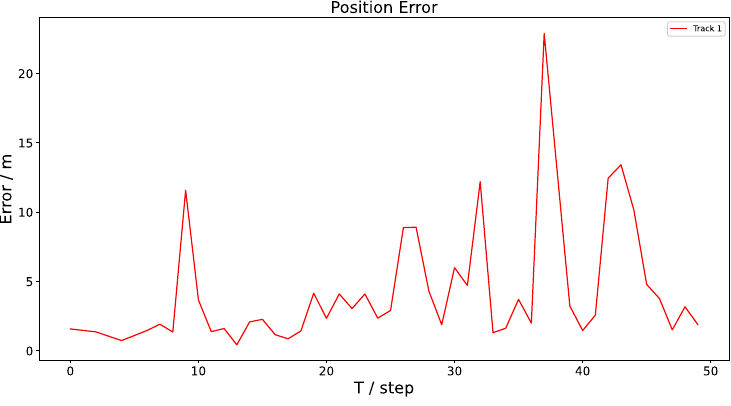
Figure 15. Tracking error between prediction and actual track (CMKF-REMTT). Figure 16. Tracking error between the prediction and actual track (REMTT).